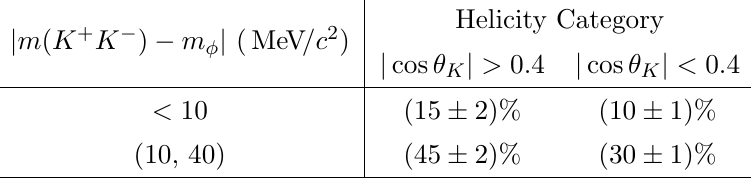
Table 2. Fractions of B + ! D + K + K (cid:0) candidates assumed to contribute to each helicity and s m ( K + K (cid:0) ) invariant mass categories of the simultaneous (cid:12)t. The uncertainties shown are calculated from the range of fractions obtained by assuming di(cid:11)erent contributing resonances, as detailed in section